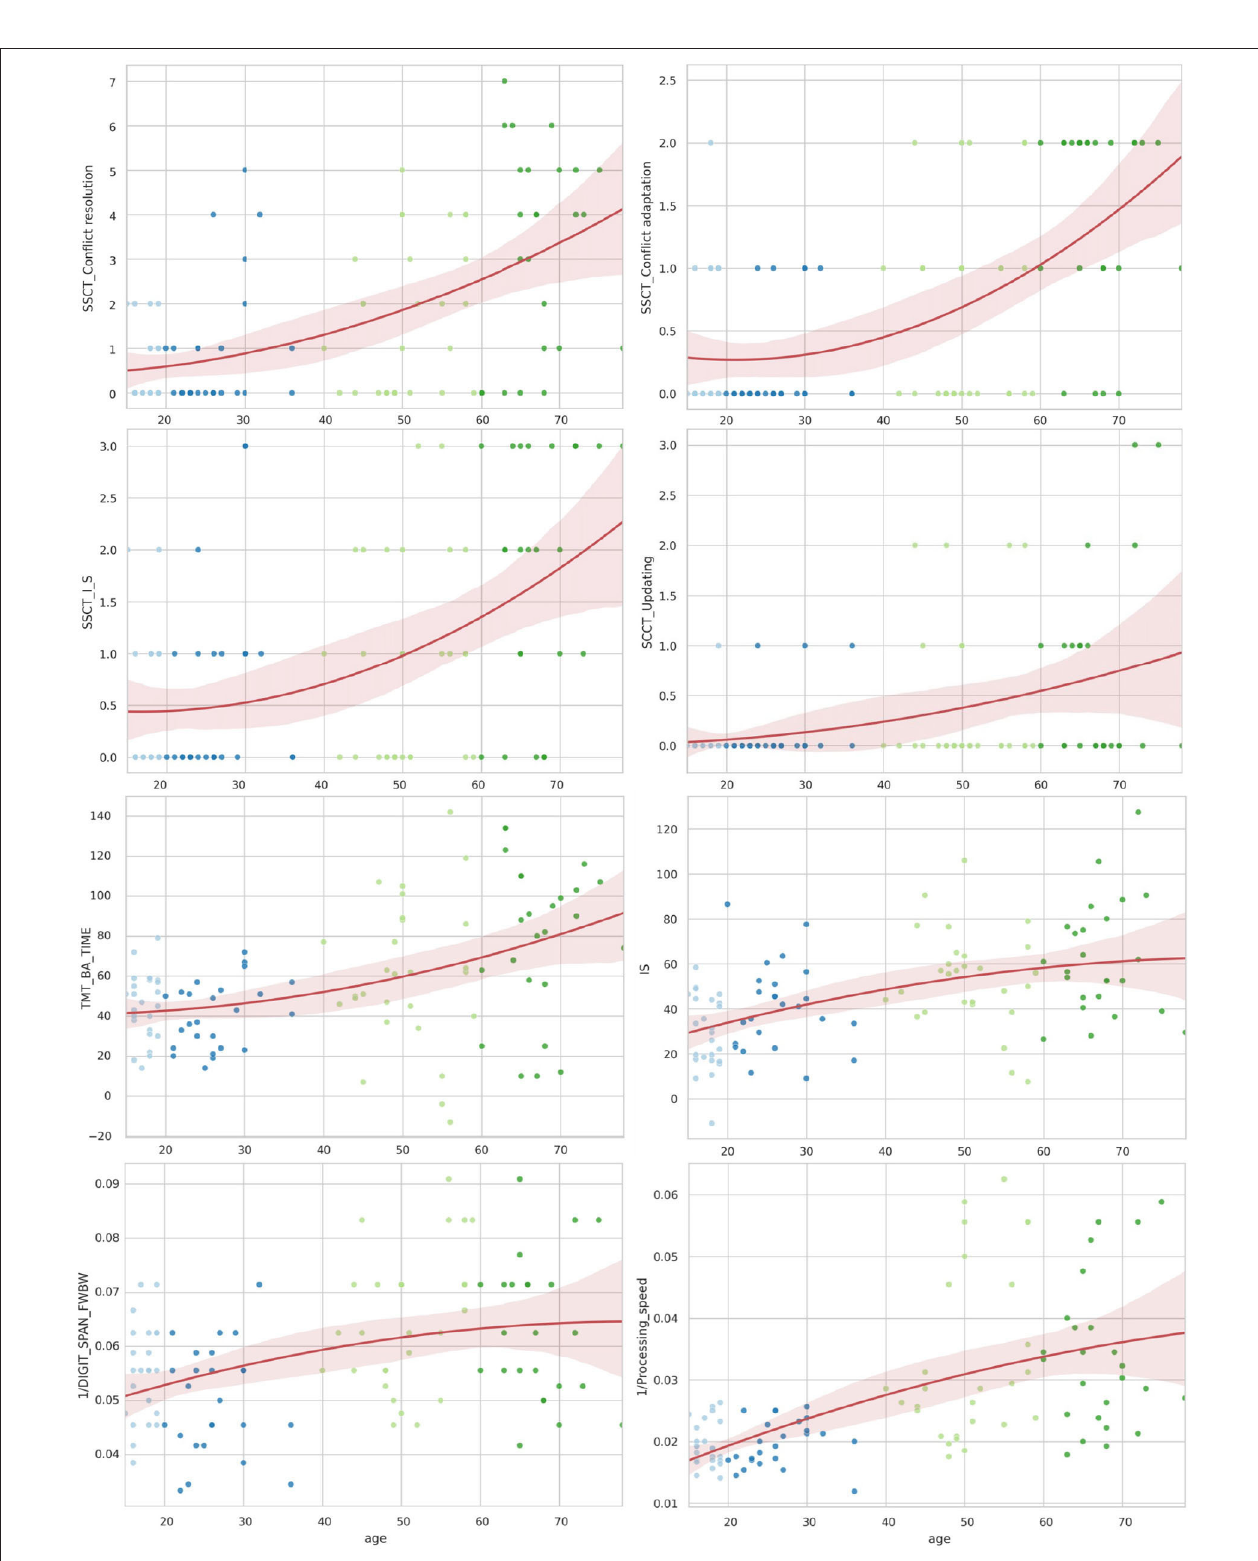
FIGURE 5 | The distribution of the Stroop switching card test, trial making test, Stroop color and word test, digit span forward and backward test, and digit symbol substitution test by age.